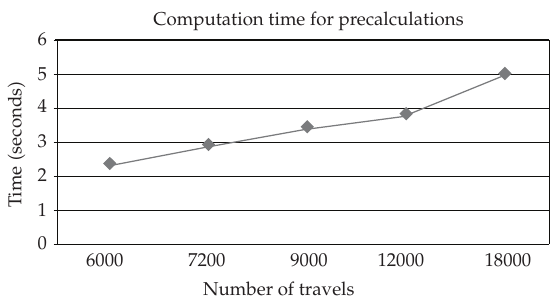
Figure 3: Computation time for precalculation in the instance SPP (cid:5) 200 , 3 (cid:6) with di ff erent numbers of travels